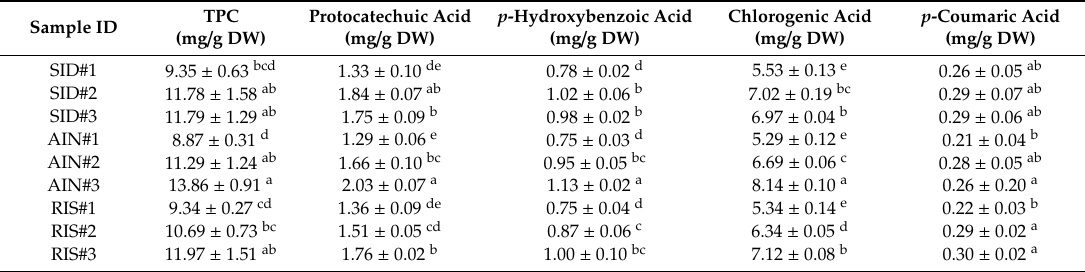
Table 7. Variations in TPC, and protocatechuic acid, p -hydroxybenzoic acid, chlorogenic acid and p -coumaric acid contents in AOR from samples of three di ff erent native Beldi genotypes produced at three di ff erent pilot locations in the Eastern